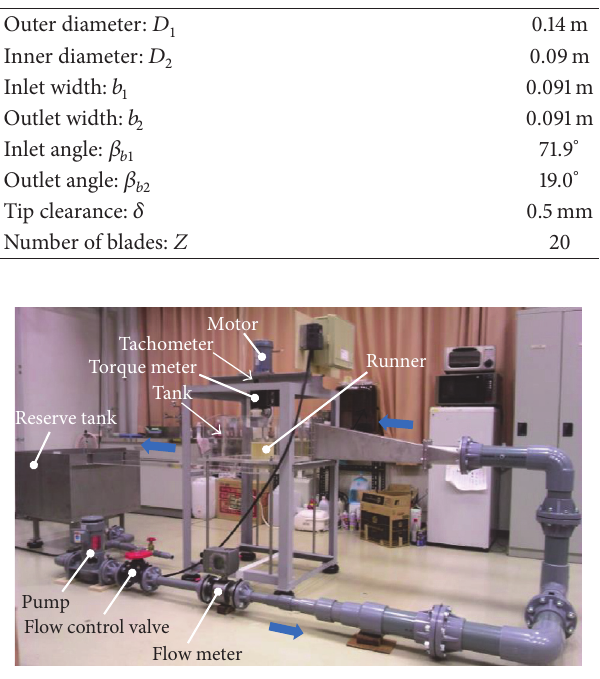
Figure 3: Experimental